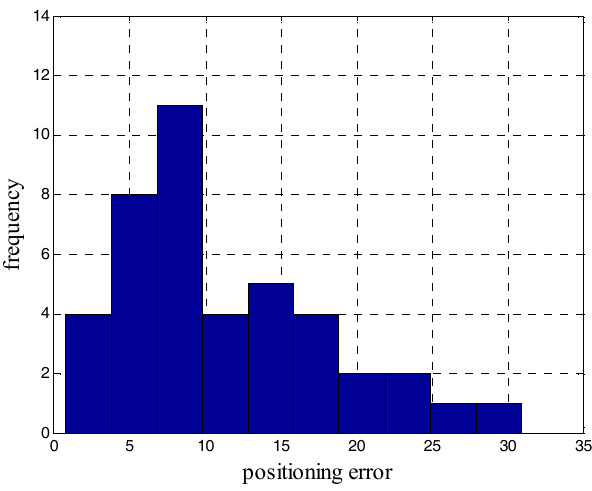
Sensors 2018 , 18, x FOR PEER REVIEW Figure 15. The positioning errors of the iQSF method. Figure 15. The positioning errors of the iQSF method.